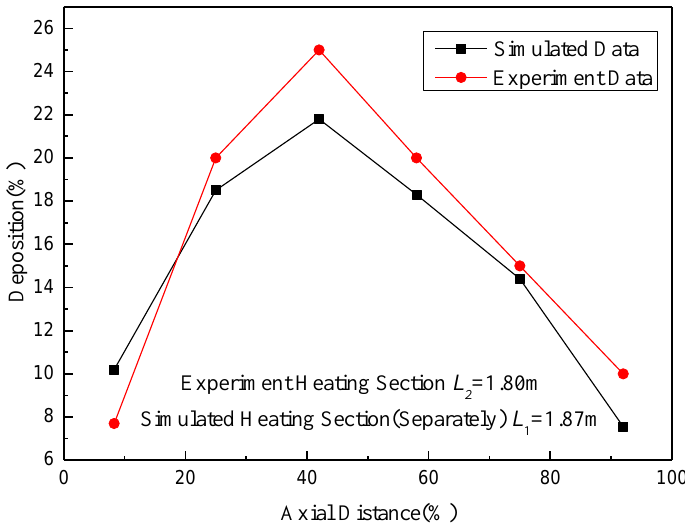
Figure16. Comparisonofsimulatedcalculationdatawithexperimentaldata(heatingsectionseparately). Figure 16. Comparison of simulated calculation data with experimental data (heating section separately). As shown in Figure 16, in this case, the changing trend of experiment and calculation is